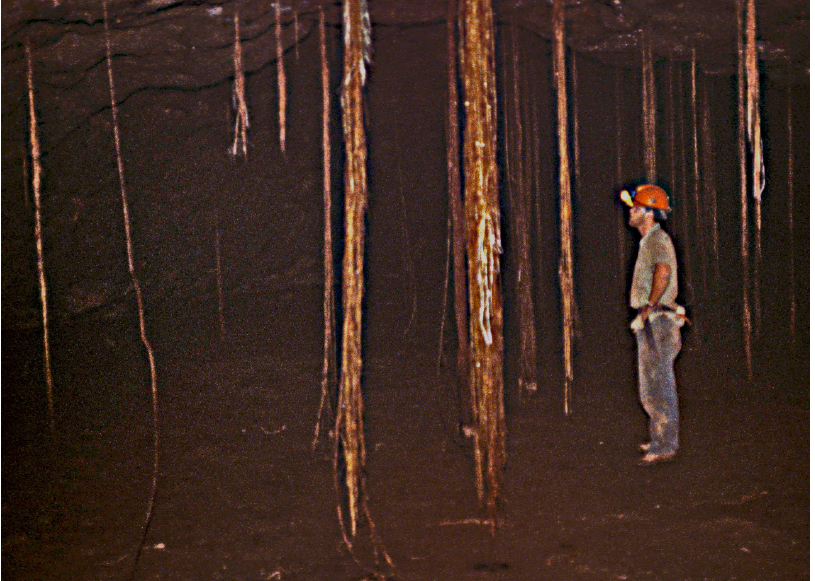
Figure 5. Root ‘curtains’ of Eucalyptus penetrate from ceiling to floor in the deep zone about 100 m beyond the Duck-Under. Photograph by F.G. Howarth.